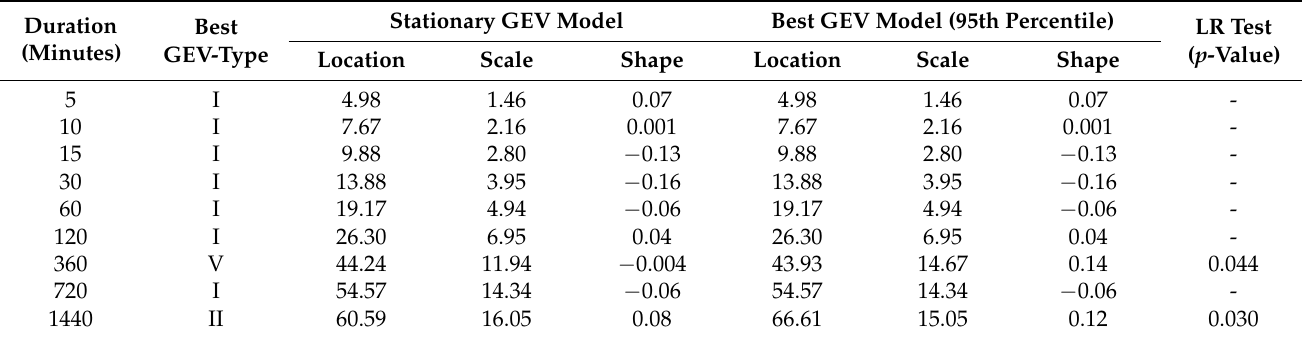
Table 5. Parameters of GEV distribution, in mm, for historical data for the Shearwater